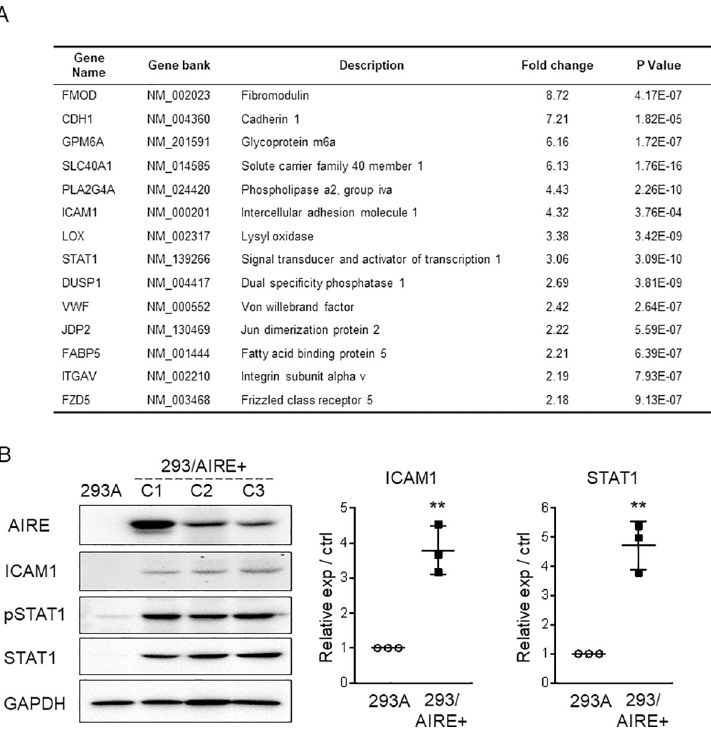
Fig 3. AIRE promotes the expression of ICAM1 and STAT1 in 293A cells. A) Genes that were upregulated more than 2-fold in in 293/AIRE+ (C-3) when compared to non-transfected 293A cells in at least three spots on the cDNA microarray. B) Left panel: Western blot analysis of ICAM1 and STAT1 in 293/AIRE+ cells. Right panel: Densitometric quantification of the western blot data. �� P < 0.01, by ratio t